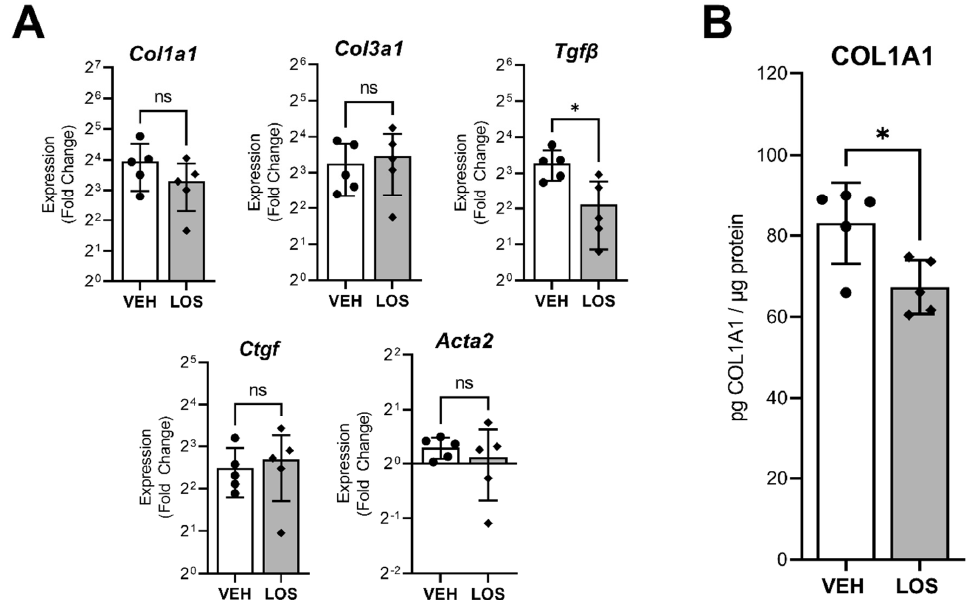
Figure 1. Evaluation of subcutaneous losartan delivery by gene expression and protein analysis at 28 days post-injury. ( A ) Transcriptional analysis of pro-fibrotic markers within a VML injury treated with either losartan (LOS) or vehicle (VEH). Bar graphs depict fold change in gene expression relative to vehicle uninjured limbs. ( B ) Quantification of COL1A1 protein levels produced in VML injured limbs by 28 days post-injury in losartan-treated (LOS) or vehicle-treated (VEH) groups. Data are presented as mean ± SD; n = 5 per group. The * indicates a significant difference of p < 0.01 by two-tailed Student’s t -test. “ns” indicates no significant difference ( p > 0.05).